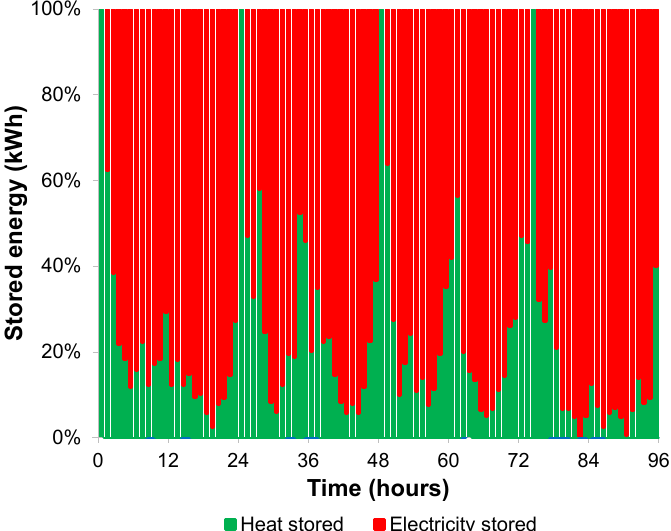
Figure 5. Split of energy stored between electricity and heating storage.